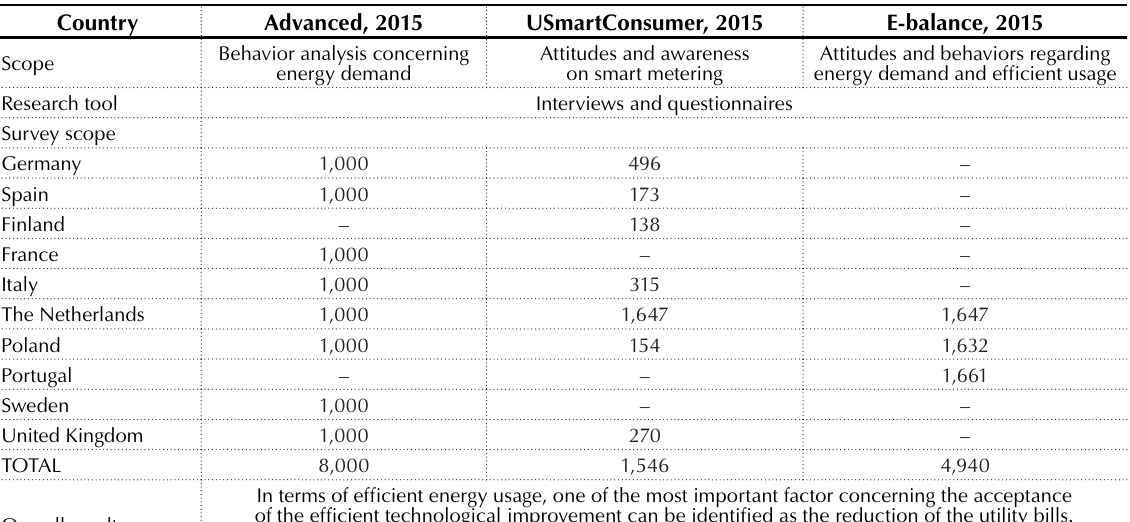
Table 1. Summary of projects on surveying energy consumer behaviors